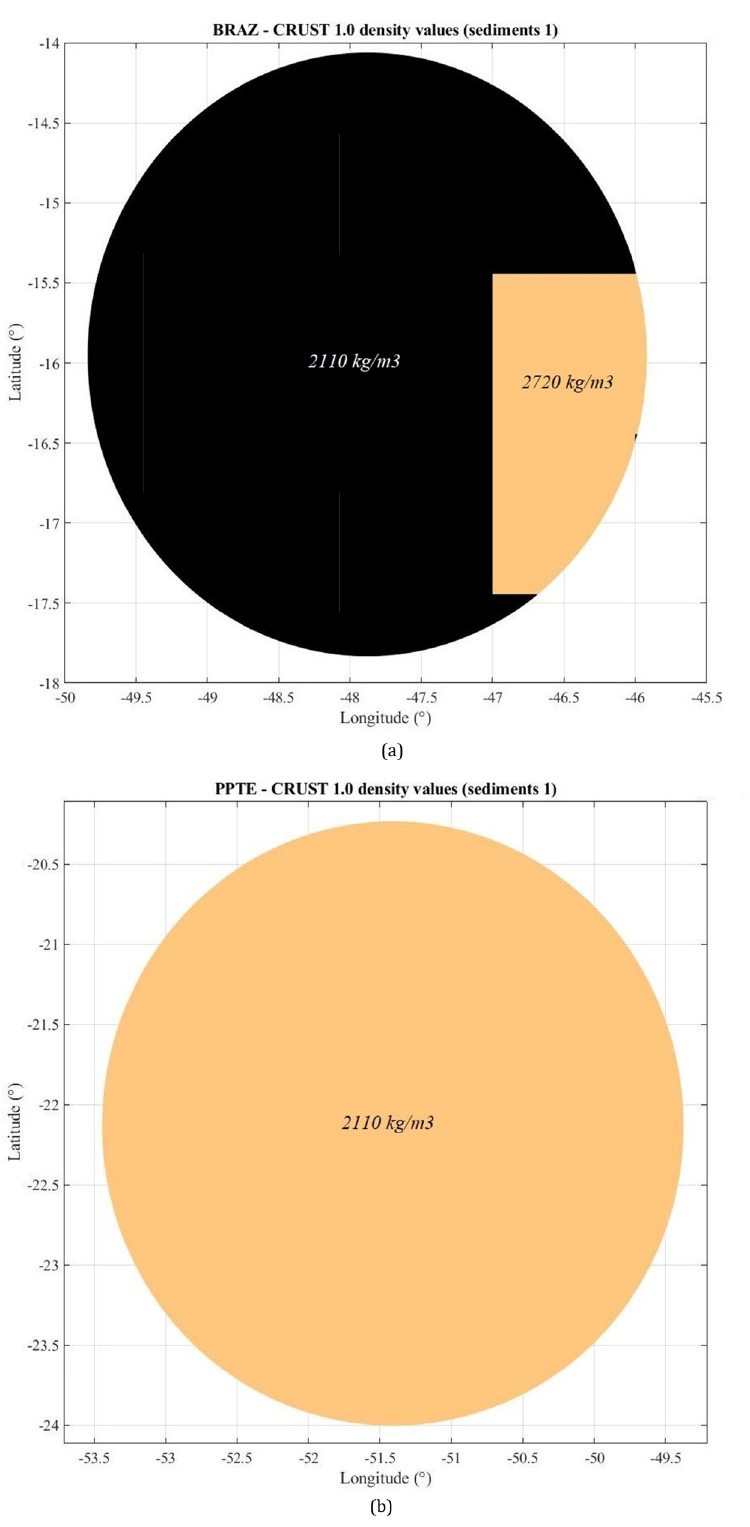
Figure 7: CRUST 1.0 density grid for sedimentary 1 layer at ( a ) BRAZ and ( b ) PPTE